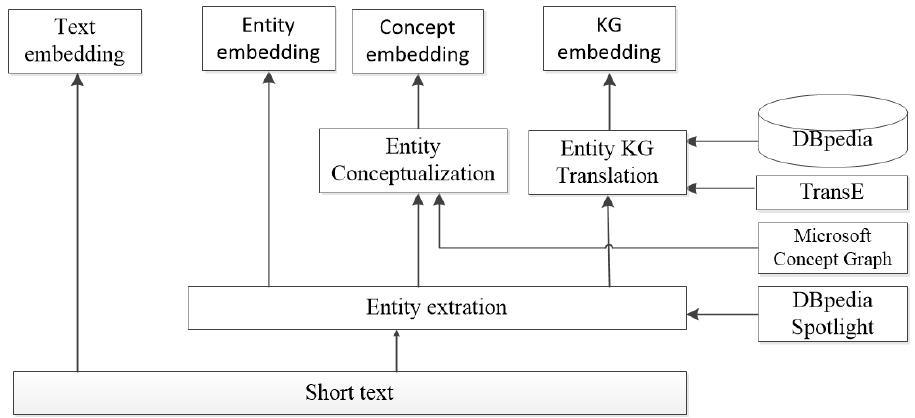
Figure 3. The semantic information retrieval